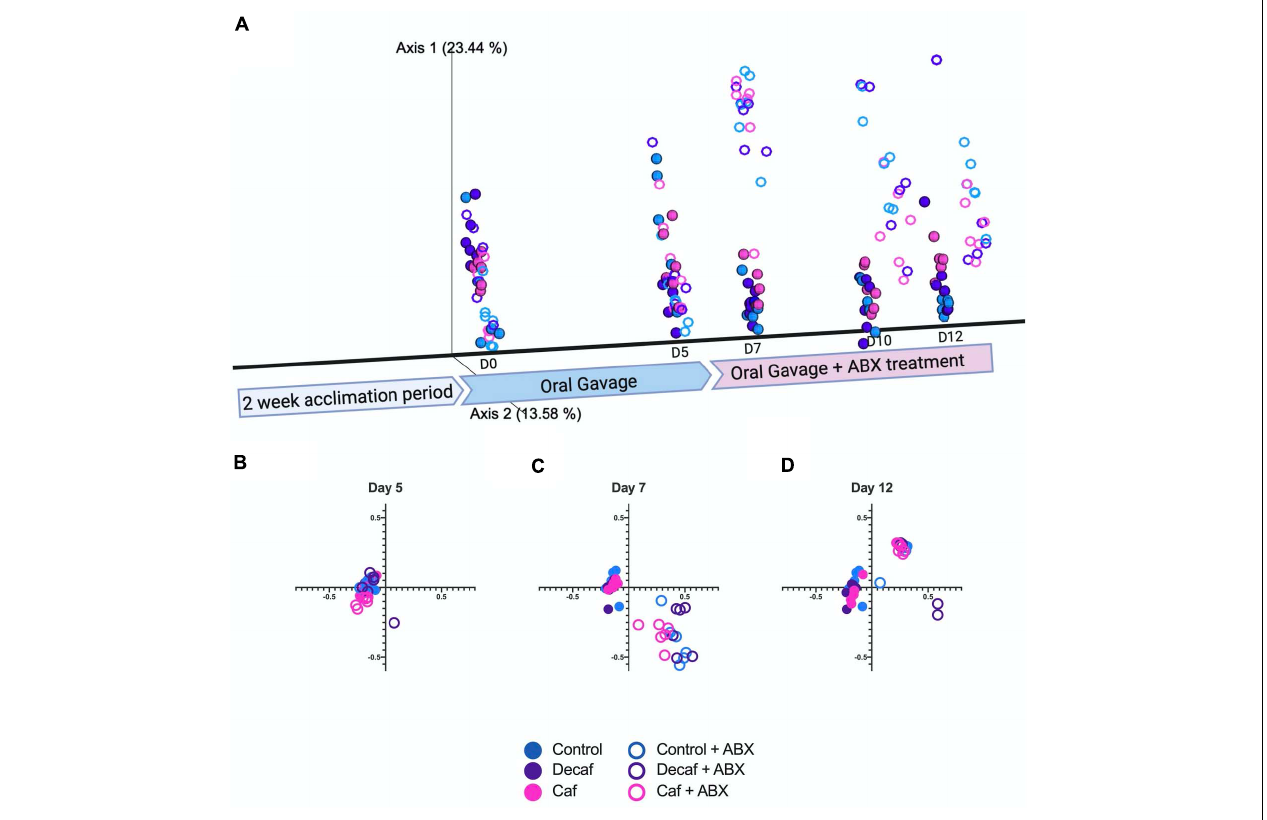
FIGURE 2 | (A) Beta diversity of experimental groups over time represented on a three-dimensional principal coordinate analysis plot. Figure was created with biorender.com. (B) Beta diversity metrics using Bray Curtis Distance Matrices at 5 days of coffee gavage, (C) 2 days of antibiotic treatment and 7 days coffee gavage, (D) 7 days of antibiotic treatment and 12 days coffee gavage; n =